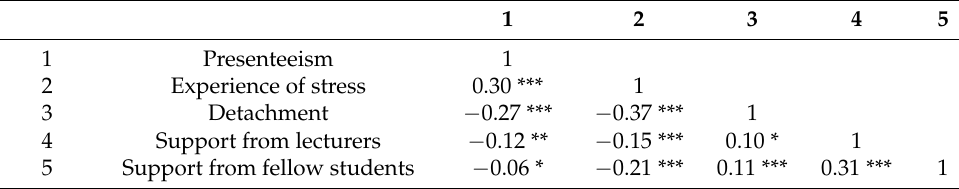
Table 5. Intercorrelations of the variables (characteristics of remote studying).